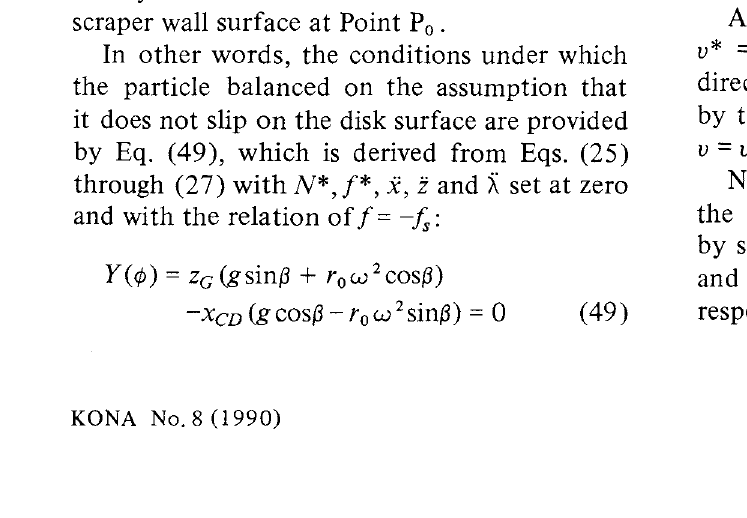
Fig. 4 Flow chart of